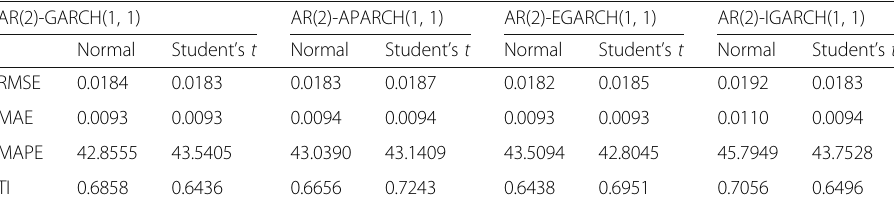
Table 8 Comparison of models in out of sample forecasting accuracy AR(2)-GARCH(1,